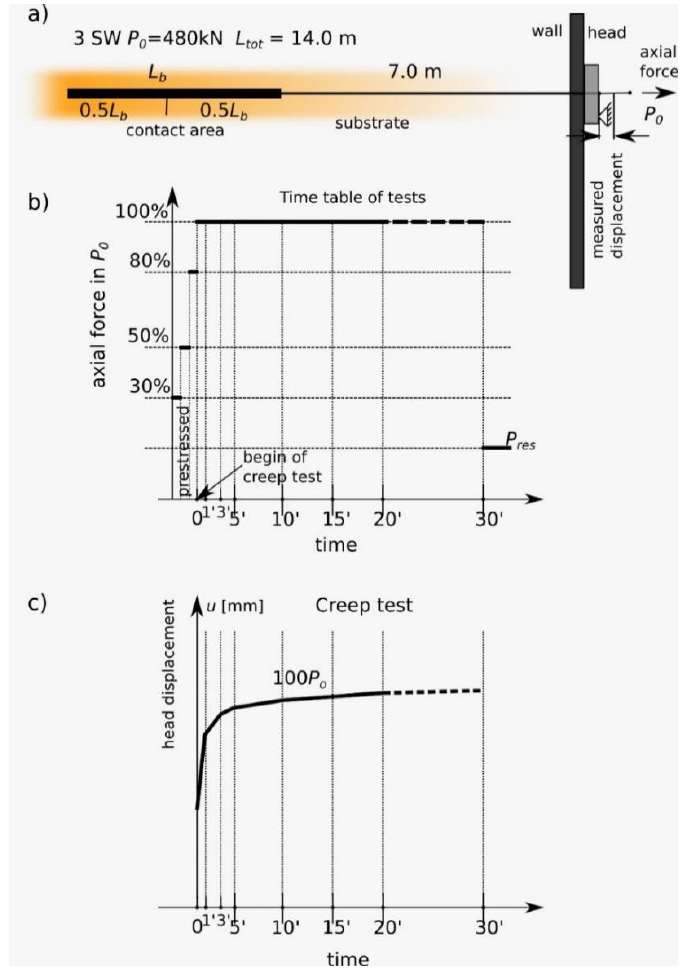
Figure 9. Example of a graphic anchor creep test report: ( a ) profile of 3SW-type anchors, which were used in construction and tested; ( b ) schedule of load – time procedure in experiments; ( c ) typical creep result chart.